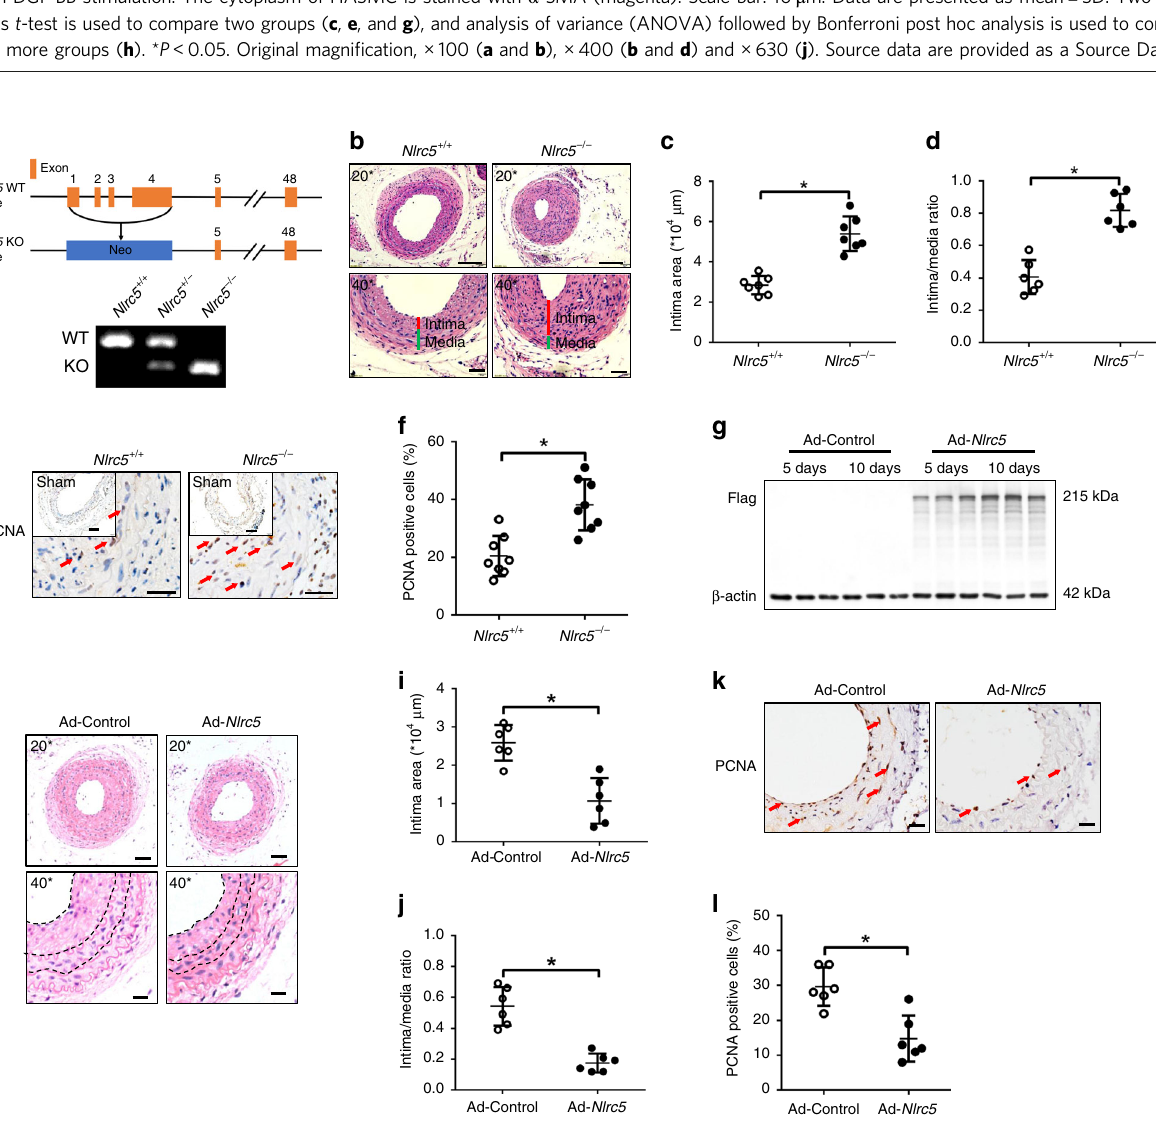
Fig. 2 NLRC5 attenuates neointimal formation in vivo. a Schematic diagram of generating Nlrc5 knockout construct. Recombination of the Nlrc5 − / − allele is examined by PCR in the Nlrc5 + / + , Nlrc5 + / − , and Nlrc5 − / − mice. b Representative images of hematoxylin/eosin-stained Nlrc5 − / − and Nlrc5 + / + mice carotid arteries at 3 weeks after carotid ligation. Scale bar: 100 μ m (upper) and 50 μ m (lower). c , d Quanti fi cation of the intima area and intima/media ratio in the histological sections ( n = 7 per group). e , f Immunohistochemistry staining (red arrow) and quantitative analysis of PCNA-positive cells in the carotids ( n = 8 per group). Five fi elds per section from each sample are analyzed. Scale bar: 100 and 20 μ m. g Western blotting of Flag tag and β -actin in the ligated Ad-Control- and Ad- Nlrc5 -transducted carotids at 5 – 10 days following carotid ligation. h Representative images of hematoxylin/eosin-stained carotid arteries transducted with Ad-Control or Ad- Nlrc5 at 3 weeks after carotid ligation. Scale bar: 50 μ m (upper) and 20 μ m (lower). i , j Quanti fi cation of the intima area and intima/media ratio in the histological sections ( n = 6 per group). k , l Immunohistochemistry staining (red arrow) and quantitative analysis of PCNA-positive cells in the carotids transducted with Ad-Control or Ad- Nlrc5 ( n = 6 per group). Five fi elds per section from each sample are analyzed. Scale bar: 20 μ m. Data are presented as mean ± SD. Two-tailed Student ’ s t -test is used to compare two groups ( c , d , f , i , j , and l ). * P < 0.05. Original magni fi cation, × 200 ( b and h ) and × 400 ( b , e , h , and k ). Source data are provided as a Source Data fi